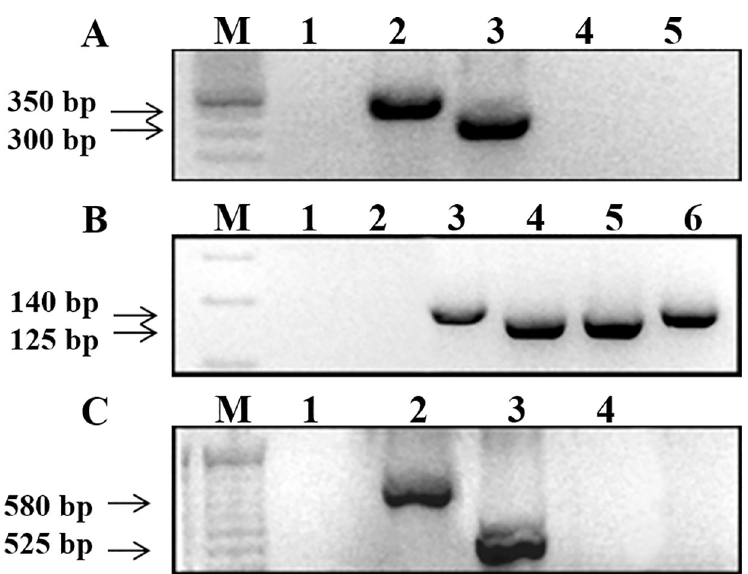
Fig 4. Multilocus conventional PCR for T . cruzi genotyping with the reference strains/clones. PCR product sizes are indicated on the left by arrows. In A, SL-IR I and II target: Lanes—1: negative control; 2: Dm28c clone (TcI); 3: Y strain (TcII); 4: INPA 4167 strain (TcIV); 5: no template control (NTC). In B, 24S α (second round) target: Lanes—1: NTC; 2: negative control; 3: Y strain; 4: INPA 3663 strain (TcIII); 5: Bug 2149 clone (TcV); 6: CL strain (TcVI). In C,